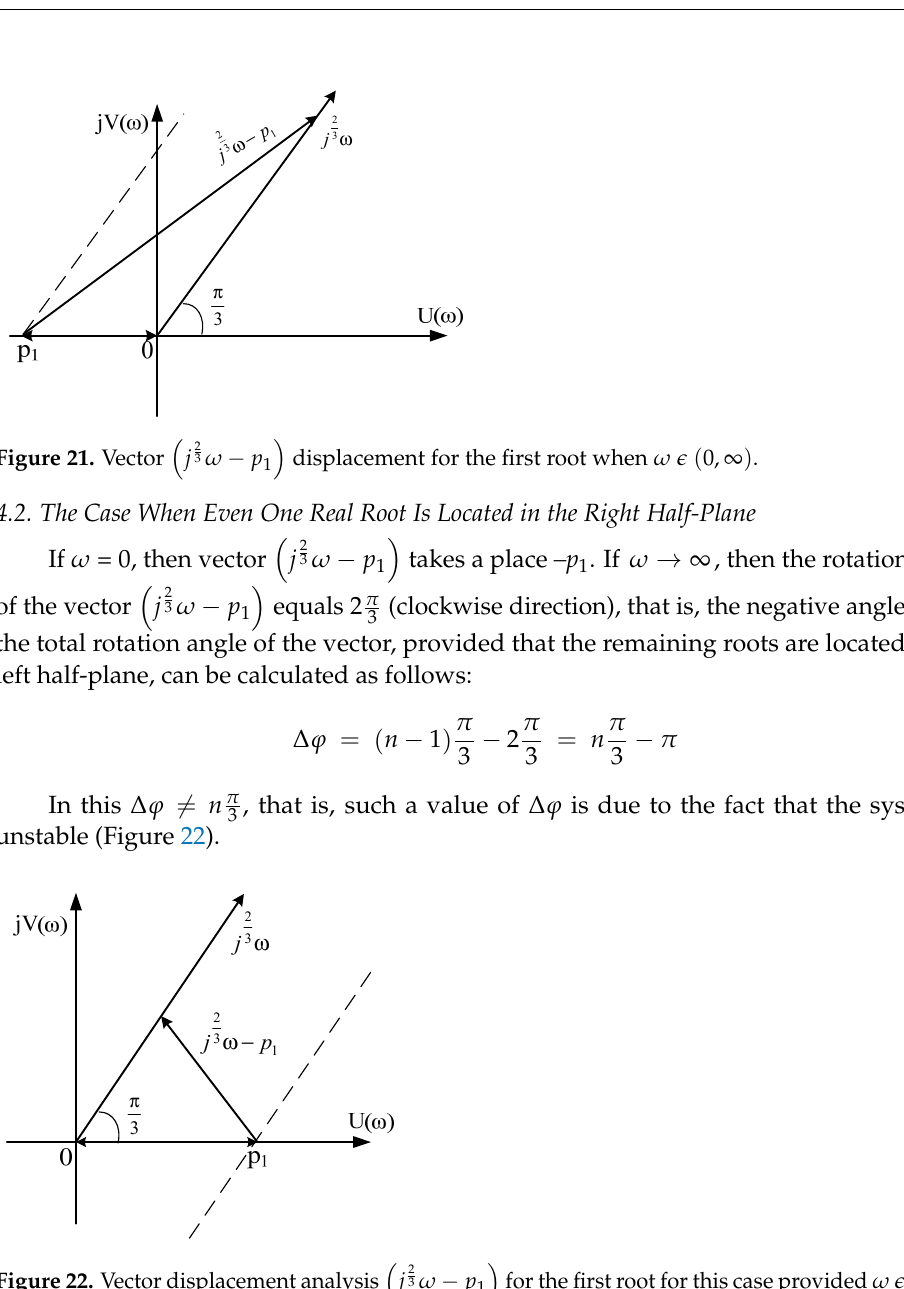
(cid:3118) (cid:3119) 𝜔 − 𝑝 (cid:2869) ) for the first root for this case provided